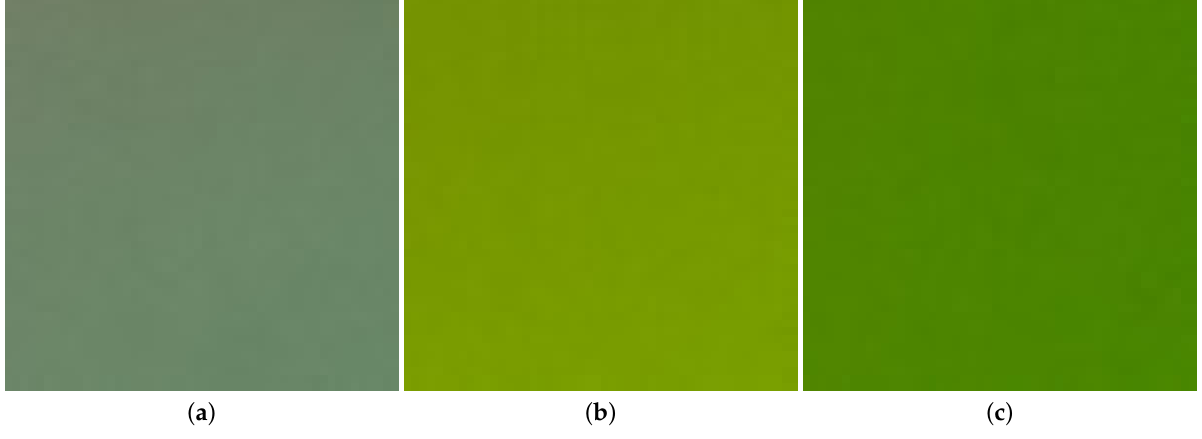
Figure 1. Examples of the cropped images of microalgae corresponding to density of ( a ) 5.08 million cells per mL, ( b ) 22.02 million cells per mL, and ( c ) 41.88 million cells per